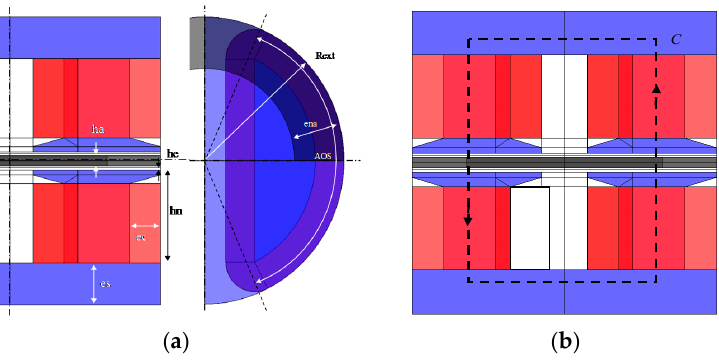
Figure 5. Direct drive actuator parameters ( a ) and the flux line contour C in axial flux machine ( b ).